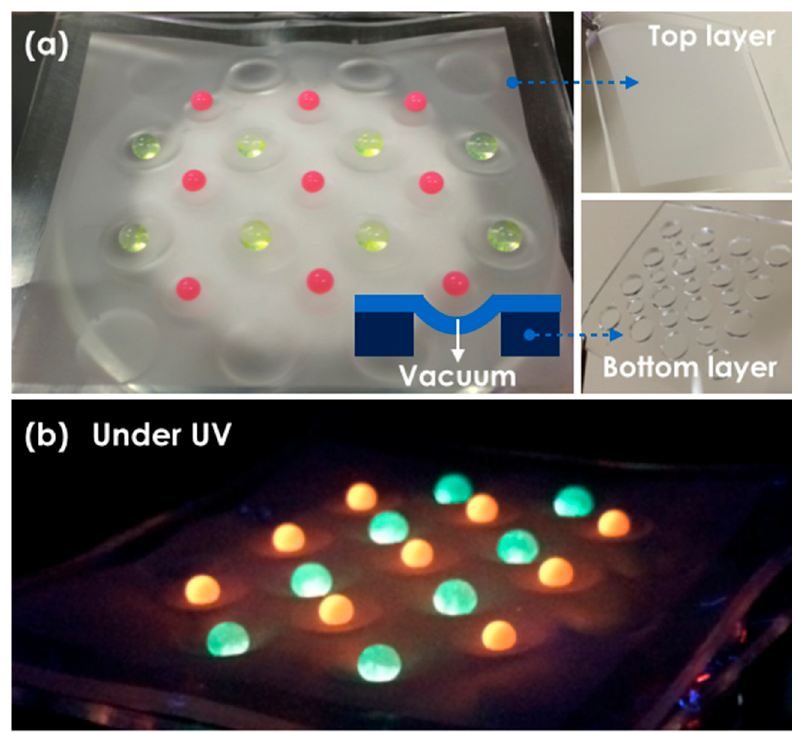
Figure 5. Pneumatically deformed flexible PDMS superhydrophobic film: ( a ) droplets with fluorescence particles were positioned on the deformed zone. The volumes of the red and yellow droplets were 5 and 10 μ L, respectively; ( b ) a tilted photograph under UV irradiation.